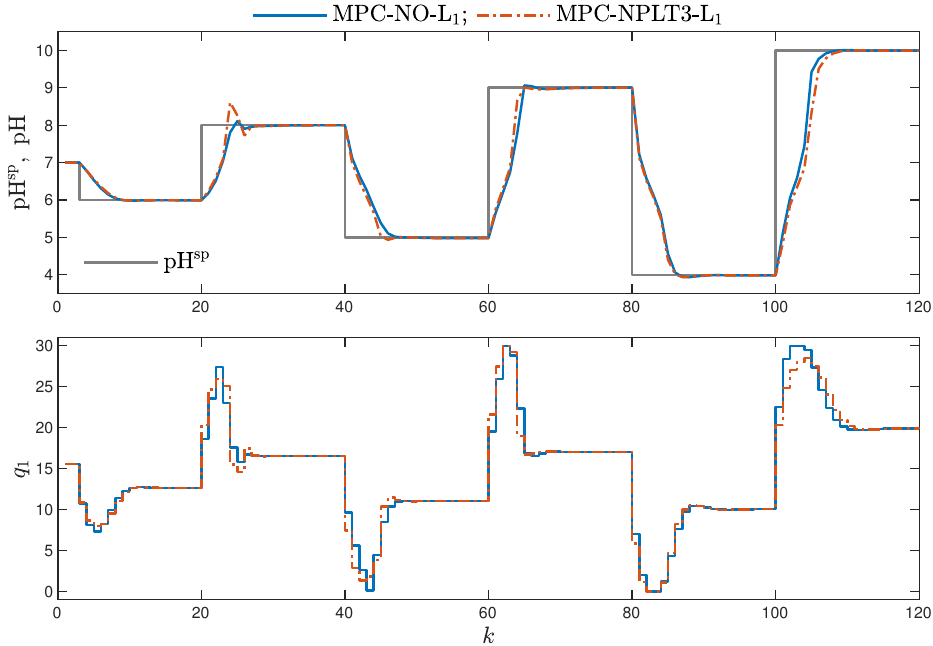
Figure 4. Simulation results: the MPC-NO-L 1 and MPC-NPLT3-L 1